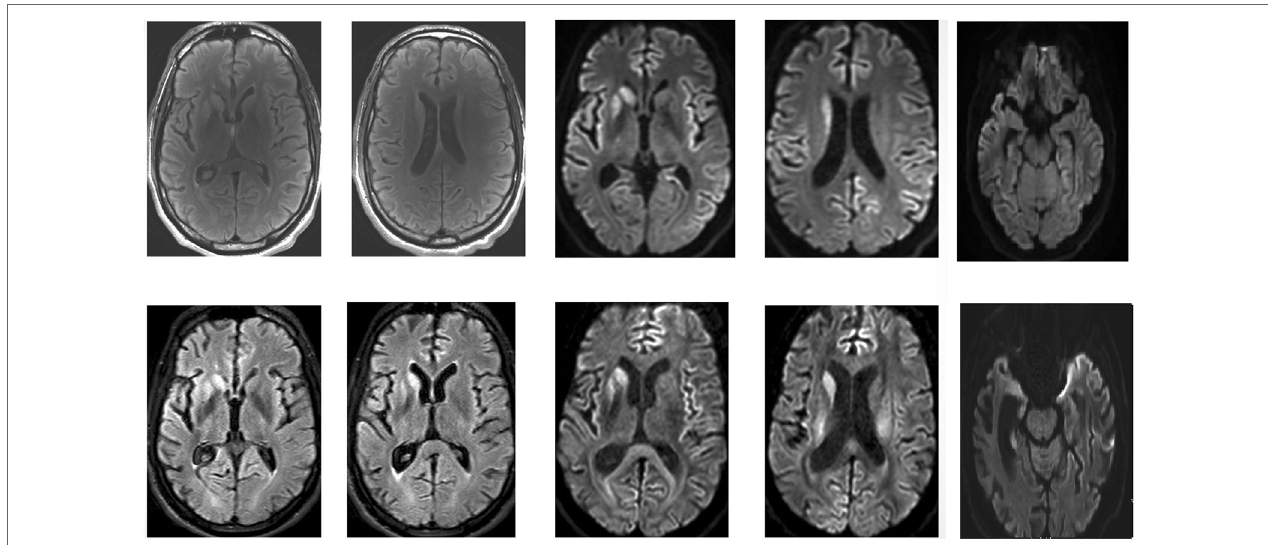
FIguRe 1 | Magnetic resonance imaging of the patient’s brain. Top: April 2016. Bottom: May 2016. Asymmetric T2, fluid-attenuation inversion recovery (FLAIR), and diffusion-weighted (DWI) hyperintensities in the putamen and caudate, as well as frontal and temporal cortical regions of restricted diffusion are clearly